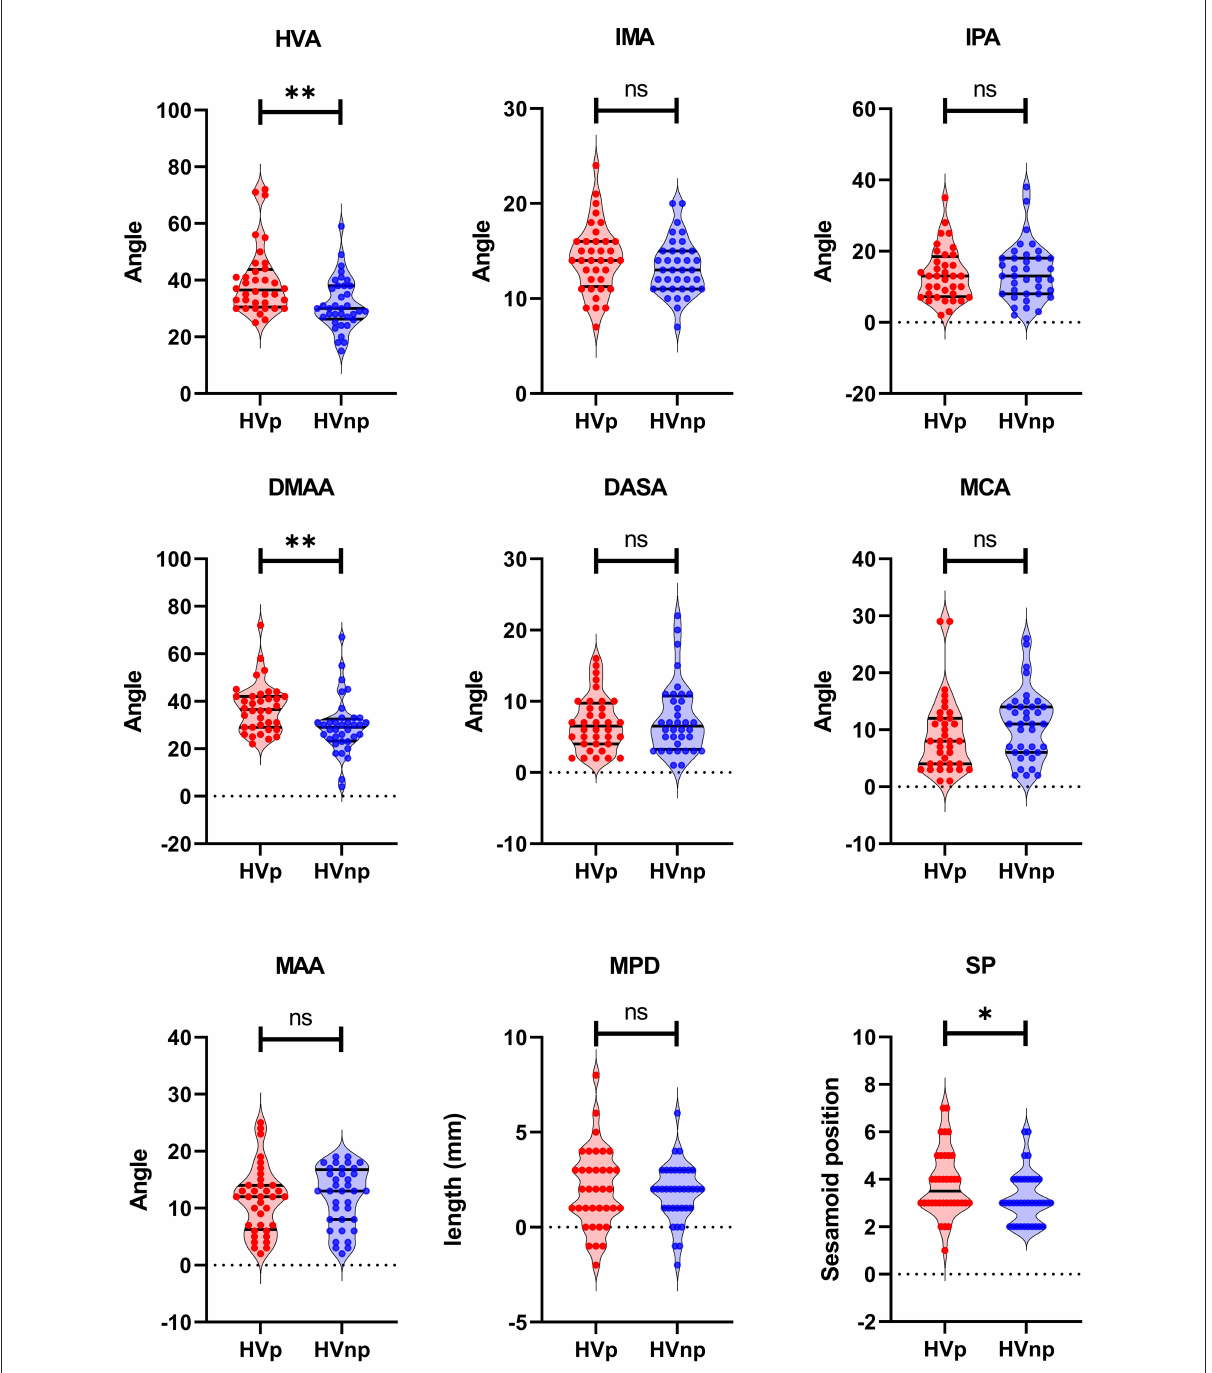
FIGURE1 Univariate differences for radiographic metrics between painful and pain-free HV. HVp, Hallux Valgus with Pain; HVnp, Hallux Valgus without Pain; HVA, Hallux Valgus Angle; IMA, Inter-Metatarsal Angle; IPA, Inter-Phalangeal Angle; DMAA, Distal Metatarsal Articular Angle; DASA, Distal Articular Set Angle; MCA, Metatarsal Cuneiform Angle; MAA, Metatarsal Adducent Angle; MPD, Metatarsal Protrusion Distance; SP, Sesamoid Position. ** P < 0.005; * P < 0.05. ns means